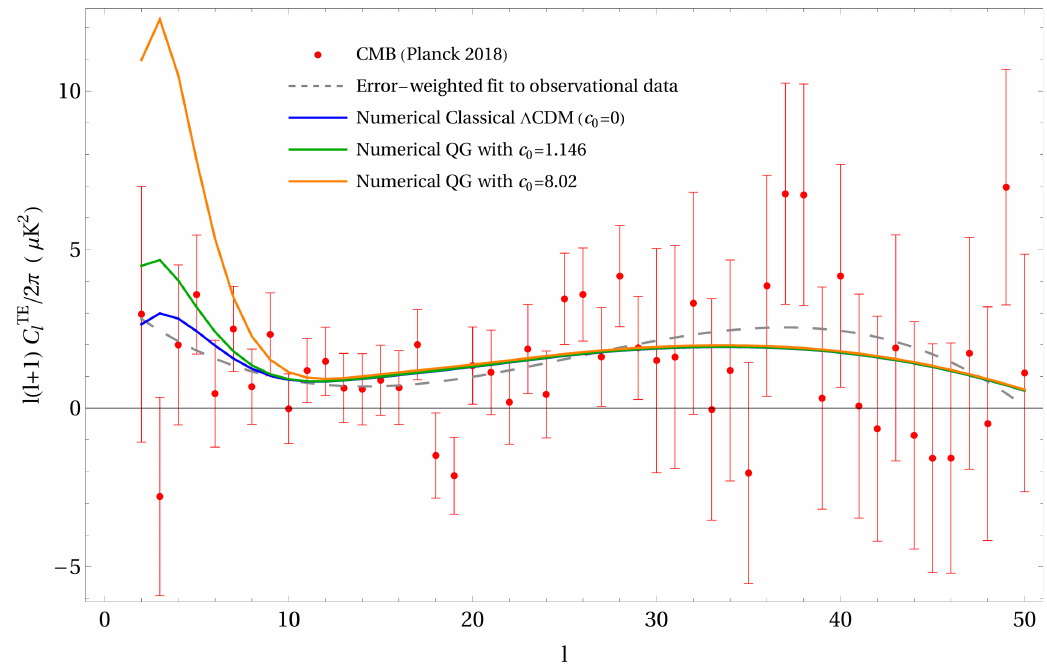
Figure 5. Comparison of the numerical prediction of the classical Λ CDM program vs. the numerical predictions of the RG running of Newton’s constant’s effect on the cross-temperature-E-mode- polarization (TE) power spectrum C TE . The solid curves represent the numerical predictions generated l by the ISiTGR program, with the bottom (blue), middle (green) and top (orange) representing quantum amplitudes (see Equation (9)) quantum amplitudes (see Equation (9)) c 0 = 0,1.146,8.02, respectively. Here again one finds higher trends at large angular scales ( l < 10) as compared to the classical (no running) numerical Λ CDM curve. The dashed curve represents an error-weighted cubic fit to the observational CMB data from Planck (2018)